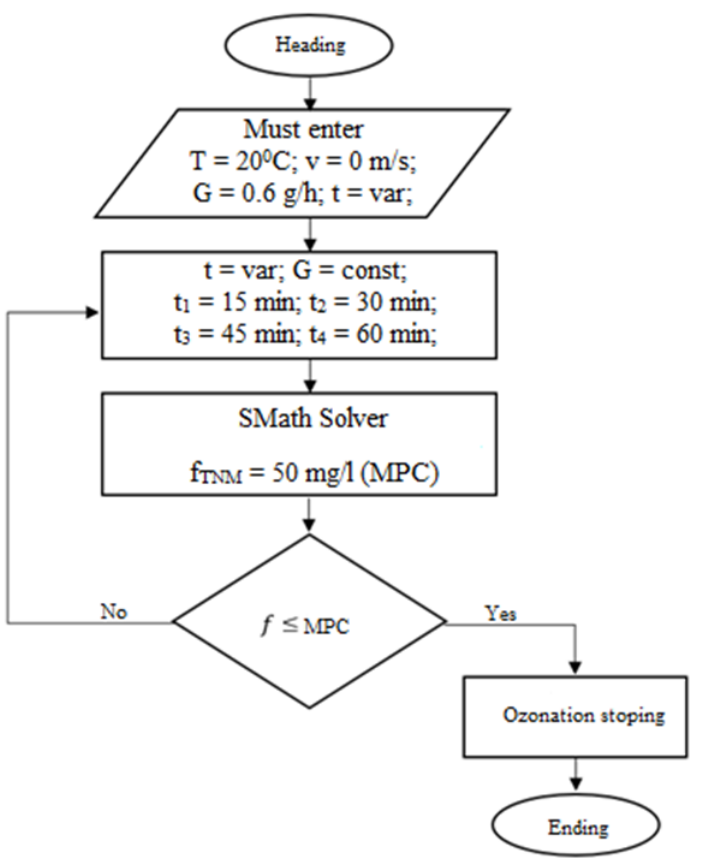
Figure 8. Algorithm of the process of destruction of harmful microorganisms in water (Gozone = const.). Must enter: T = 200 C; v = 0 m/s; G = 0.6 g/h; t = var.